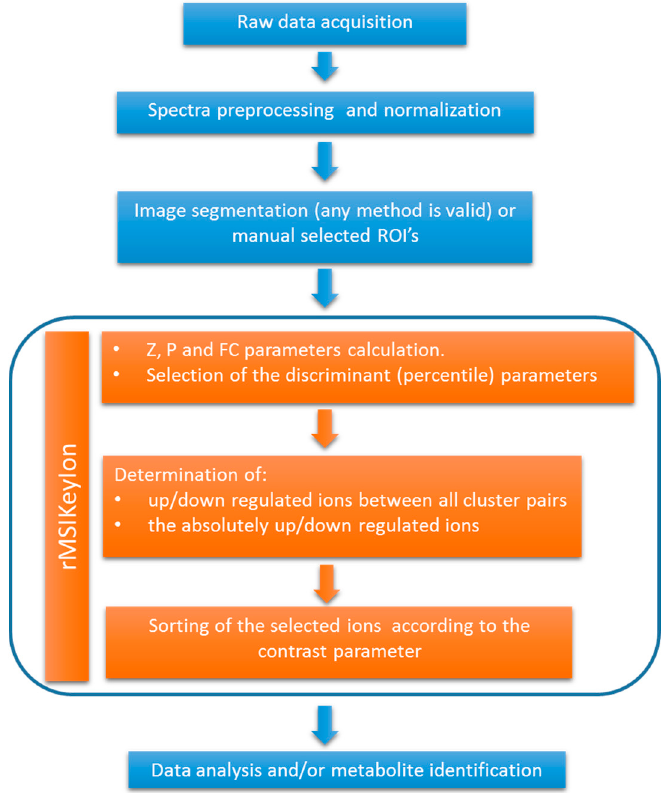
Figure 1. Workflow of the data processing, indicating the steps performed by the rMSIKeyIon package.